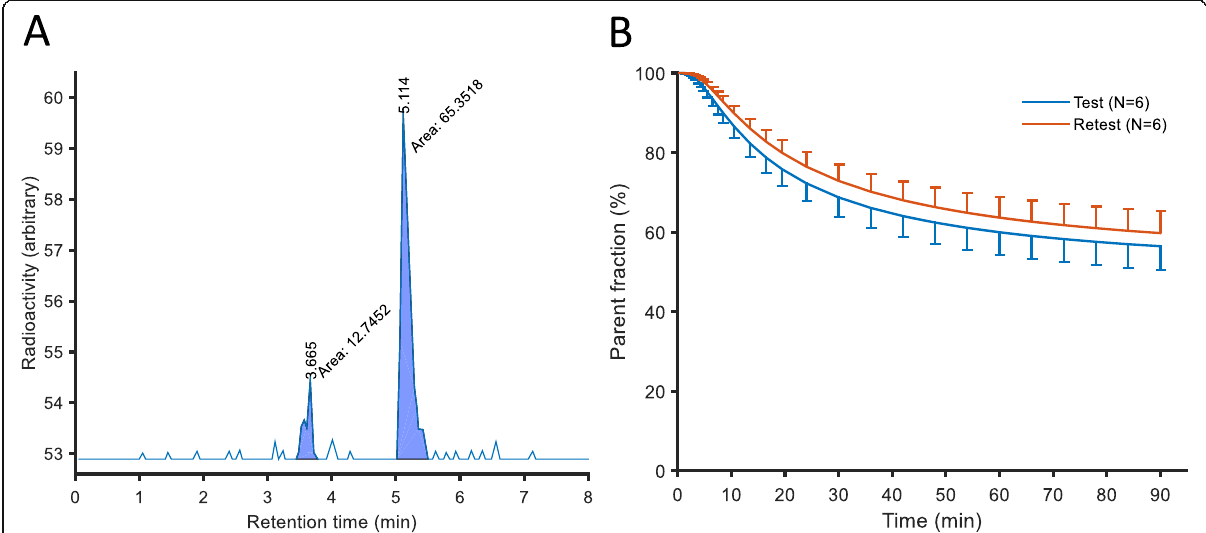
Fig. 3 a Radiochromatogram from gradient HPLC analysis of human plasma at 30 min after I.V. injection of [ 11 C]VC-002 in subject #1. The larger peak to the right represents unchanged [ 11 C]VC-002, whereas the left peak represents a radioactively labelled metabolite that is more polar than [ 11 C]VC-002. b Time course for the fraction (%) of radioactivity in plasma representing unchanged [ 11 C]VC-002 (mean fitted curves with SD indicated using error bars). An empirical model using the Richards equation [25] was fitted to the measured parent